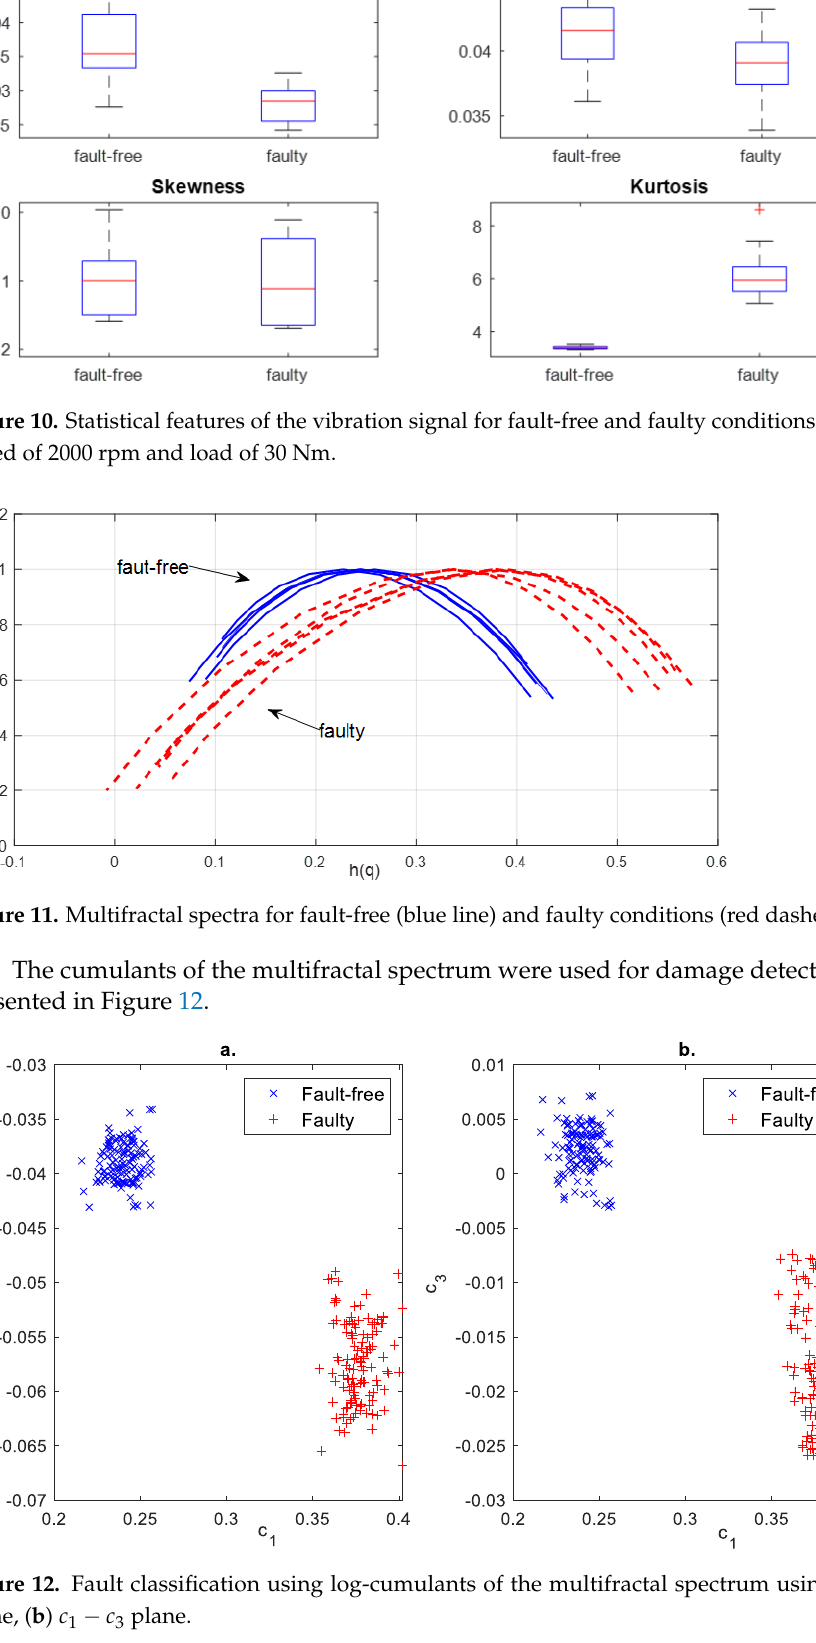
Figure 12. Fault classification using log-cumulants of the multifractal spectrum using ( a ) 𝑐 1 − 𝑐 2 plane, ( b ) 𝑐 1 − 𝑐 3 plane.